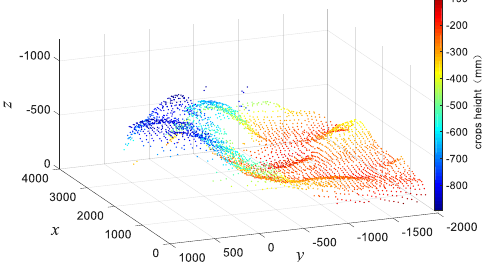
Figure 11. Processed point cloud elevation map.